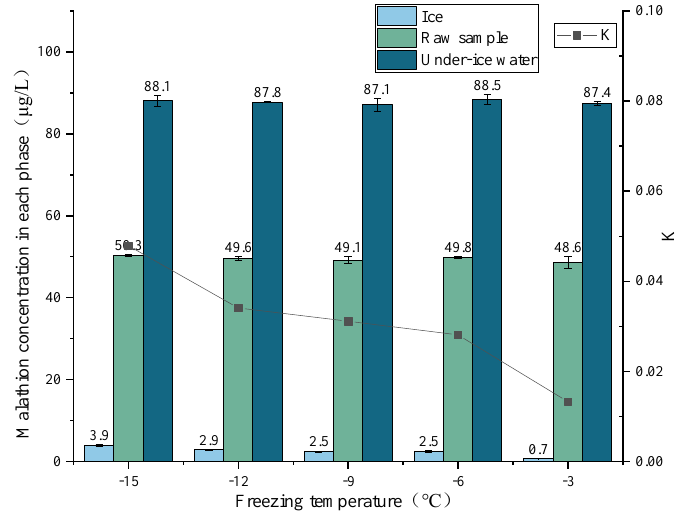
Figure 5. Migration rule of malathion at different freezing temperatures.